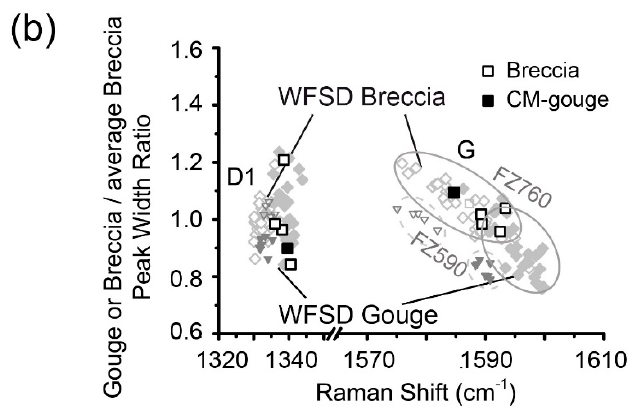
Figure 5. Decomposition of the Raman spectra of the Jiulong trench samples. ( a ) D1/G peak width ratio versus D1/G intensity ratio. The FZ590 and FZ760 results of the WFSD-1 are also included [24,41]. ( b ) G peak width of the CM-bearing gouge over the average breccia peak width versus the G band peak position. The FZ590 and FZ760 results of the WFSD-1 are also included [24,41].